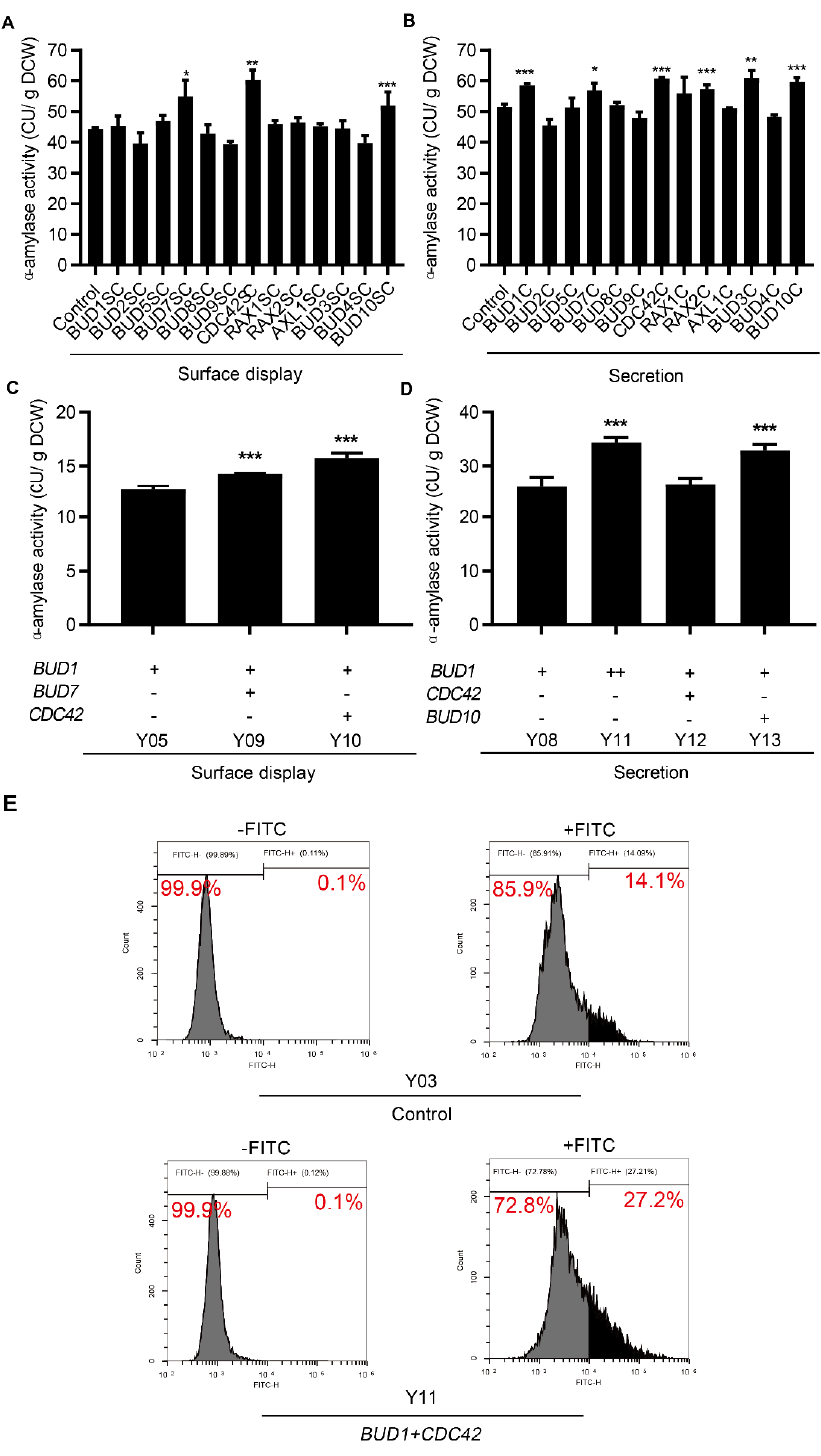
Figure 3. Effect of combinatorial modification of cell polarization on the production of α -amylase. The co-expression of BUD1 with each component affected the activity of surface-displayed ( A ) and secreted ( B ) α -amylase. The effect of genomic co-expression on surface-displayed ( C ) and secreted ( D ) α -amylase. ( E ) FACS analysis of surface-displayed α -amylase. All strains involved in ( A ) and ( B ) were cultivated in the SC − AA medium without uracil at 30 °C for 24 h, and strains involved in ( C , D ) were cultivated in the YPD medium at 30 °C for 24 h. Data are mean ± SD from three independent experiments. The statistical significance of enzymatic assays was determined by a two − tailed homoscedastic (equal variance) t -test and one asterisk represents p < 0.05, two asterisks represent p < 0.01, and three asterisks represents p < 0.005. (+, overexpressing one copy of gene; ++, overexpressing two copies of gene).